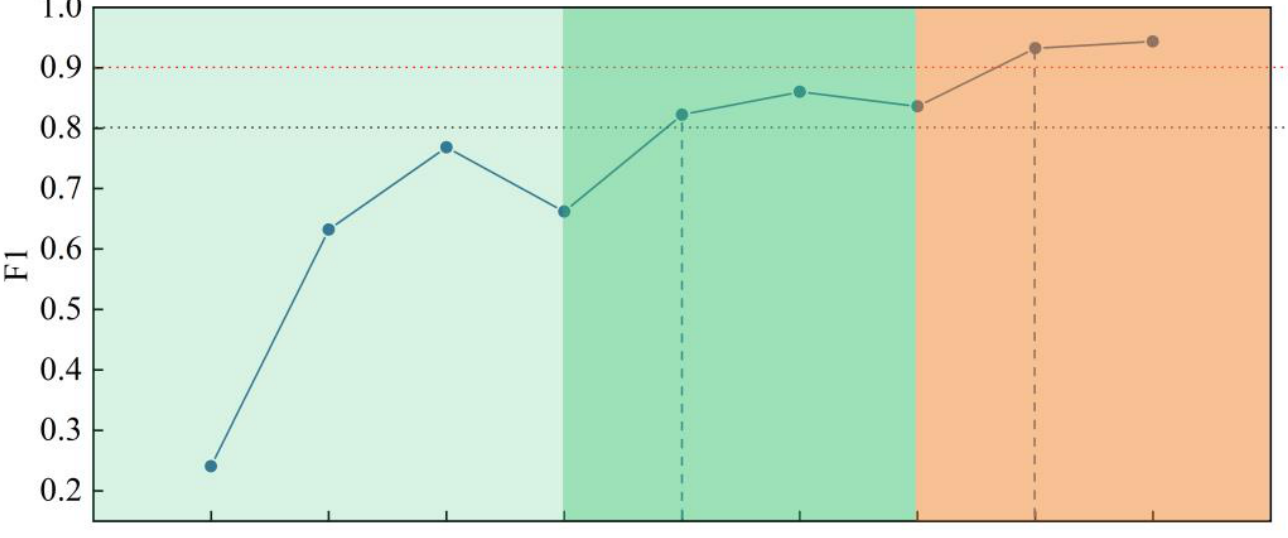
Figure 12. Accuracies of dynamic mapping (F1 scores) of paddy rice as the length of the time series increasing, which started from 16 April 2020 (light green is the vegetative phase, dark green is the reproductive phase, and orange is the ripening phase).